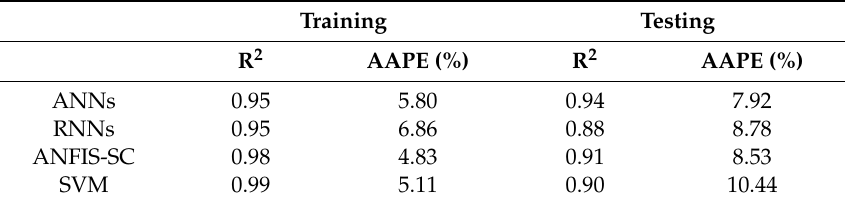
Table 4. Coe ffi cient of determinations between actual and predicted RF and the absolute average percentage error (AAPE) in predicting the RF by di ff erent AI